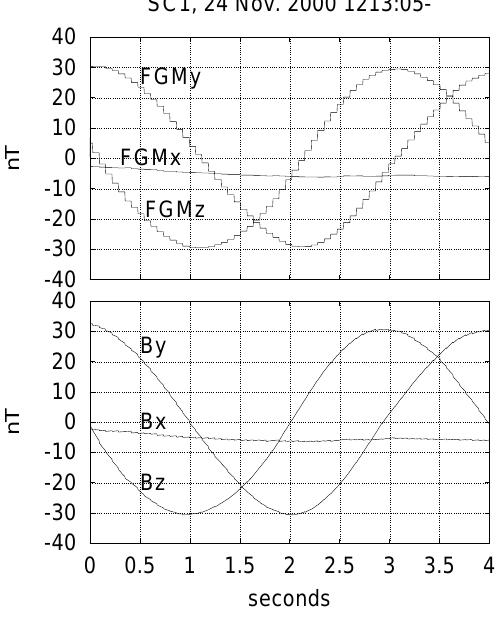
Fig. 1. EDI principle of operation. For any combination of mag- netic field B and drift velocity V d (assumed here to be induced by an electric field E ), only a single electron-trajectory exists that con- nects each gun with the detector on the opposite side of the space- craft. The two trajectories have different path lengths and thus dif- ferent times-of-flight. Note that for clarity the electron orbits are drawn for a very high drift velocity, V d = 1000 km s − 1 and an un- realistically large magnetic field, B = 12 µ T, implying an equally unrealistically large electric field of 12Vm − 1 , but a reasonable drift step of d = 3m. For realistic magnetic fields, the gyro radius is much larger, e.g. 1065m for a 100nT field.